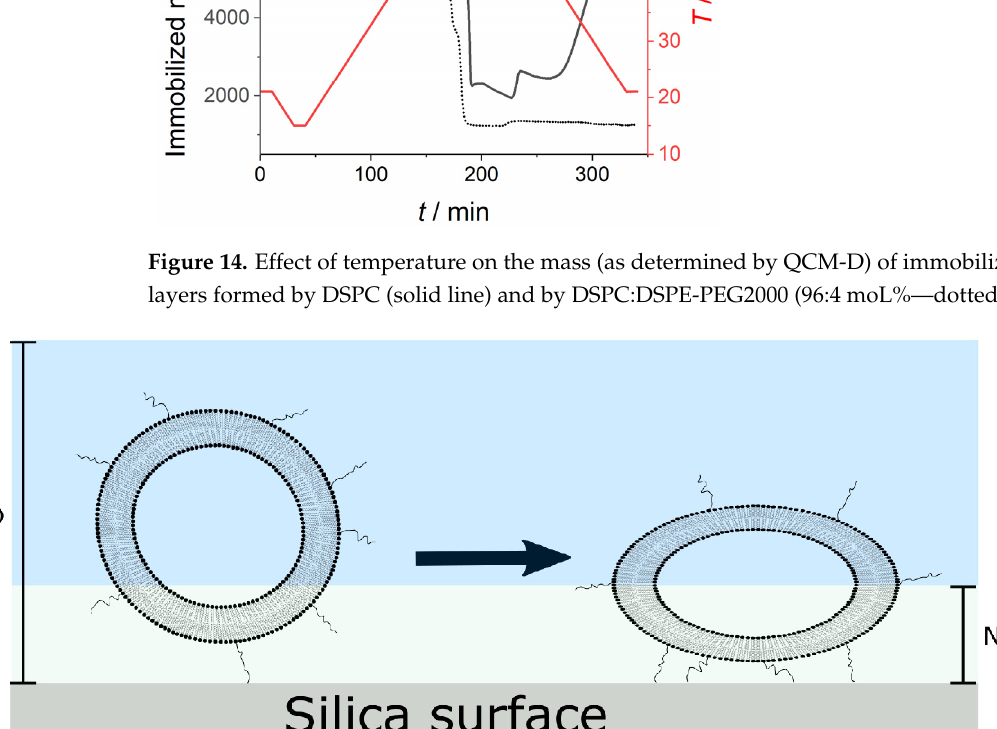
Figure 15. Representation of the proposed rearrangement of PEGylated gel-phase liposomes on silica surfaces. The QCM-D measurement includes the lipids and attached water whereas the NPS measurement only accounts for the lipids.